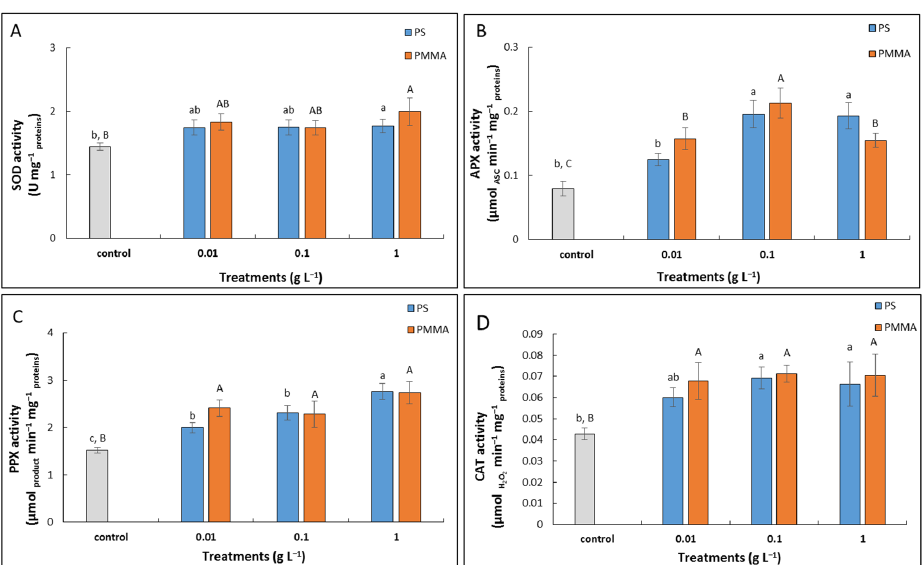
Figure 7. Activities of superoxide dismutase (SOD) ( A ), ascorbate peroxidase (APX) ( B ), pyrogallol peroxidase (PPX) ( C ), and catalase (CAT) ( D ) in A. cepa control roots and after 72 h treatment with 0.01, 0.1, and 1 g L − 1 of PS-MPs and PMMA-MPs. Values are means ± standard errors of two different experiments, each with 6 replicas ( n = 12). If columns are marked with different letters or asterisk, the treatments are significantly different at p ≤ 0.05 (one-way ANOVA followed by Duncan post hoc test); small letters mark the differences among different concentrations of PS-MPs and control, and capital letters mark the differences among different concentrations of PMMA-MPs and control.